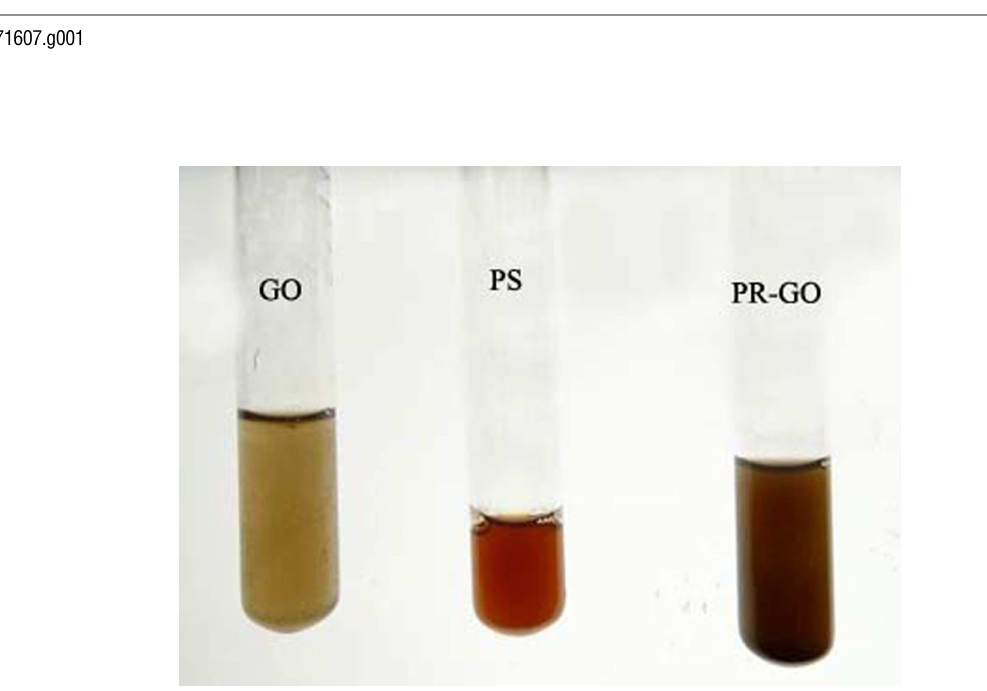
PLOS ONE | DOI:10.1371/journal.pone.0171607 February 3,